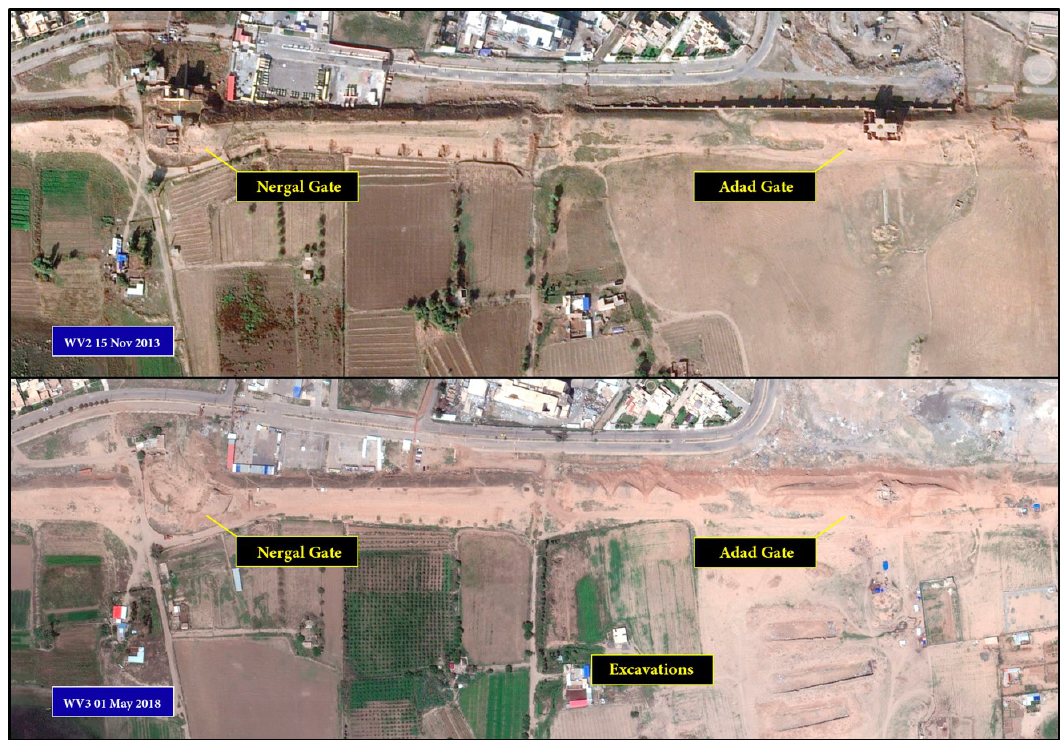
Figure 29. Visual comparison of the damages produced on Nergal and Adad Gates sites between 15 November 2013 (WorldView-2) and 1 May 2018 (WorldView-2), c (cid:13)